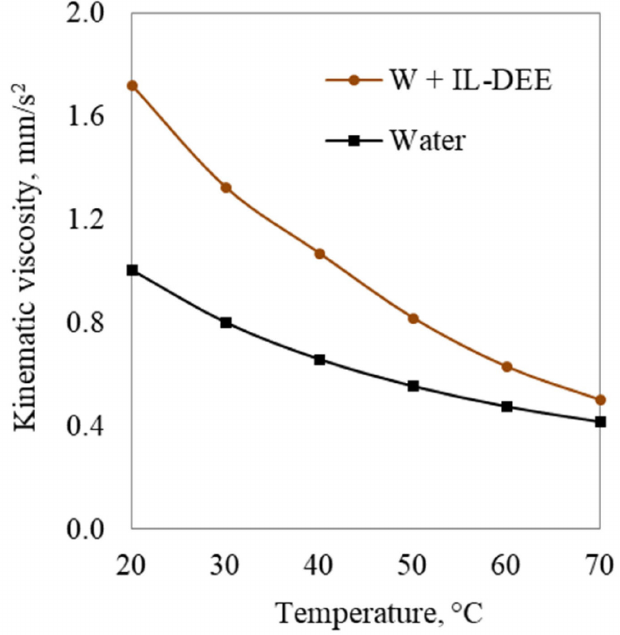
Figure 7. Kinematic viscosity of pure and 1% of IL-DEE-loaded water as a function of temperature.